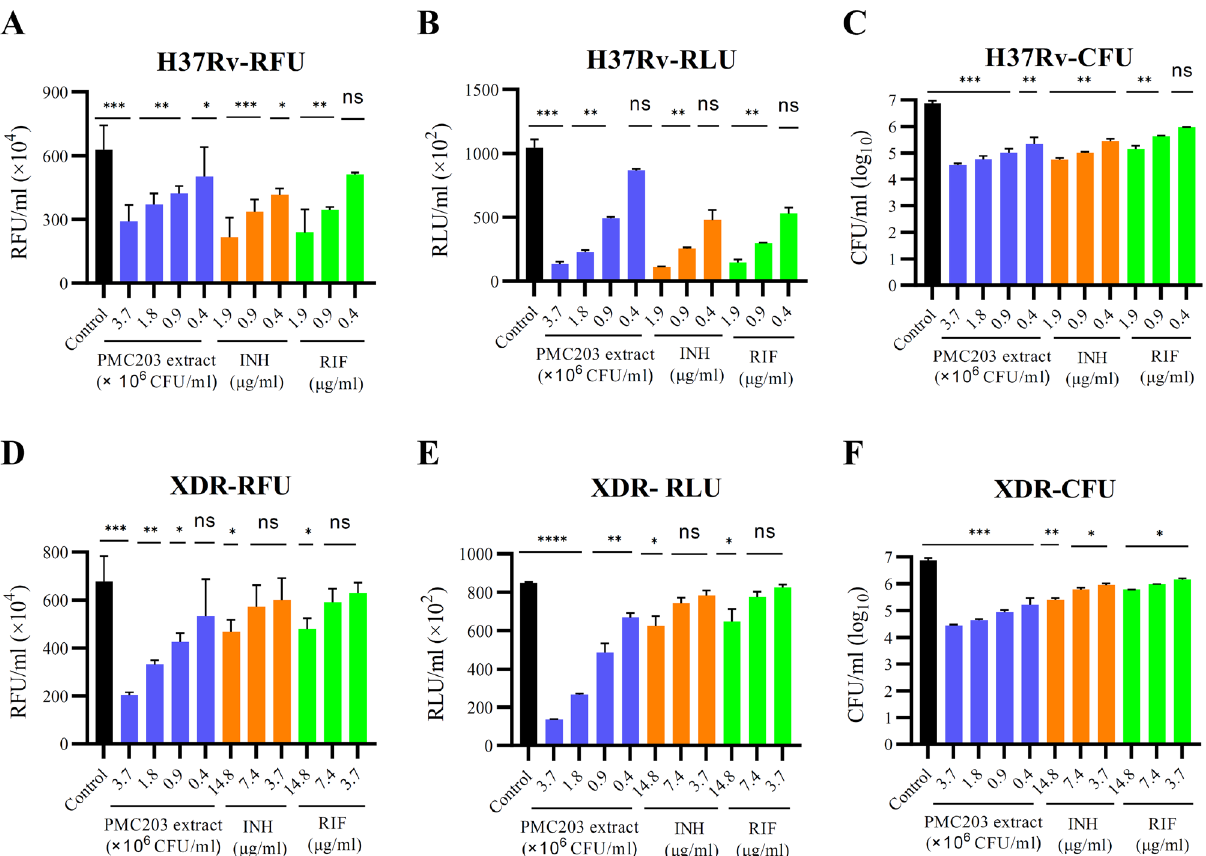
Figure 5. Antimicrobial activities of PMC203 against M. tb. The inhibitory effect of PMC203 extract against ( A – C ) H37Rv or ( D – F ) XDR strains was evaluated. Mycobacterial susceptibility was checked by ( A , D ) resazurin assay as RFU/ml (relative fluorescence unit per ml), by ( B , E ) microbial cell viability assay as RLU/ml (relative luminescence unit per ml), and by ( C , F ) CFU quantification assay as CFU/ml. These experiments were performed three times in triplicate. Values are expressed as mean values and standard deviations. *Statistical significance with controls were determined using Graph Pad Prism 9.1.1, one-way ANOVA (*p < 0.05, **p < 0.01, ***p < 0.001, ****p <